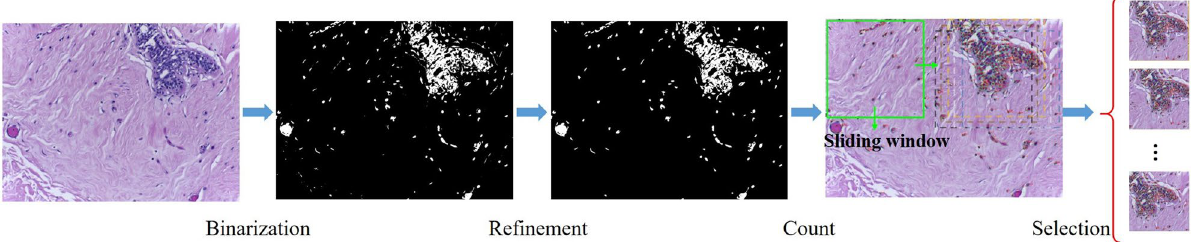
Figure 2. Diagram showing how the KREM extracts image patches. The extraction process includes four key steps: binarization, refinement, count, and